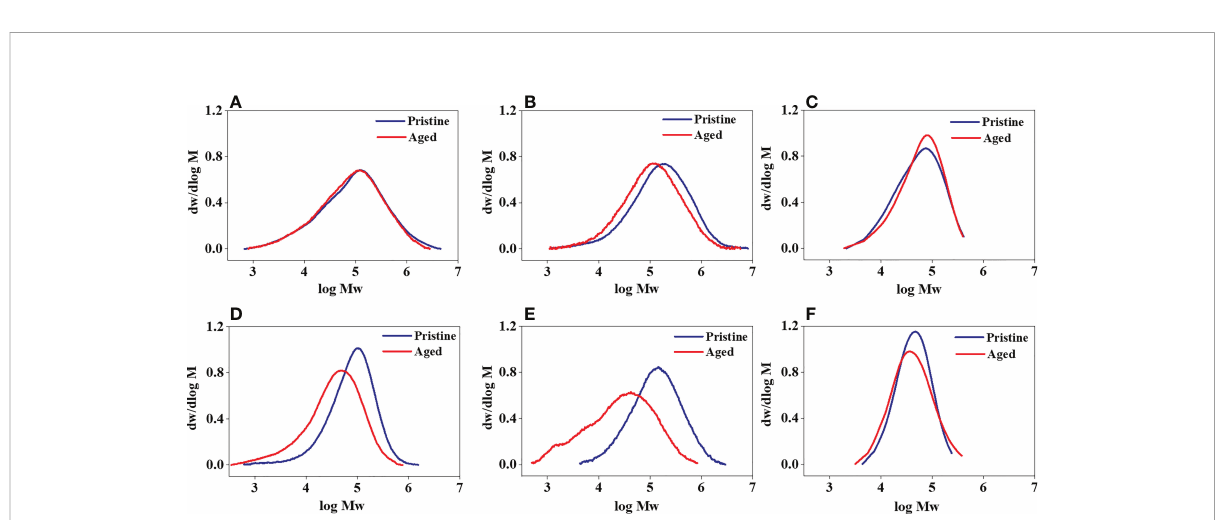
FIGURE 6 Molecularweightdistributioncurves ofthepristineandagedMPstreated by2months of UVirradiationinnaturalseawater. (A) PE, (B) PP, (C) PLA, (D) PE/ TPS, (E) PP/TPS,and (F) PLA/PBAT/TPS. PE, polyethylene;PP, polypropylene;PLA, polylacticacid;PE/TPS, polyethylene/thermoplasticstarchblends;PP/ TPS,polypropylene/thermoplasticstarchblends;andPLA/PBAT/TPS,polylacticacid/poly(butyleneadipate- co